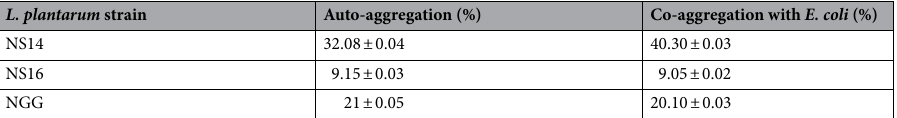
Table 5. Relative auto-aggregation and co-aggregation capabilities of L. plantarum strains. The mean of three values ± SD are presented.